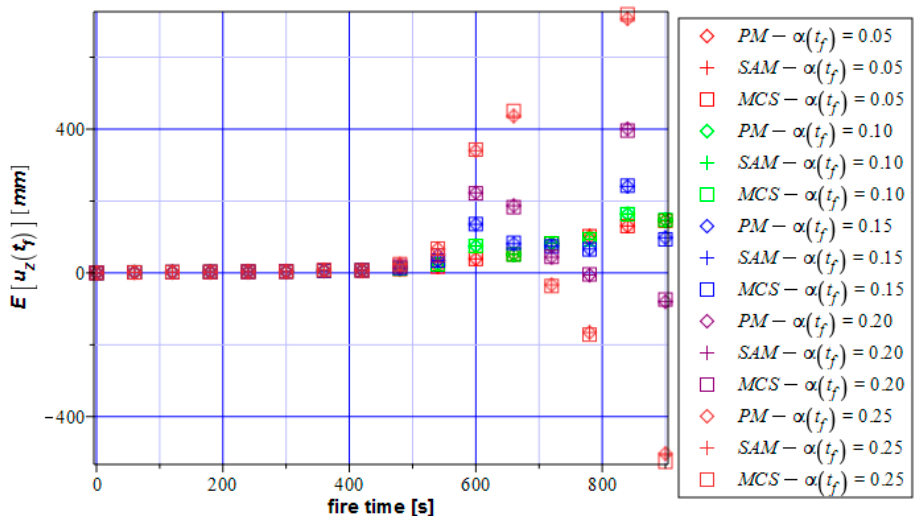
Figure 11. Expectations of the vertical deflections.